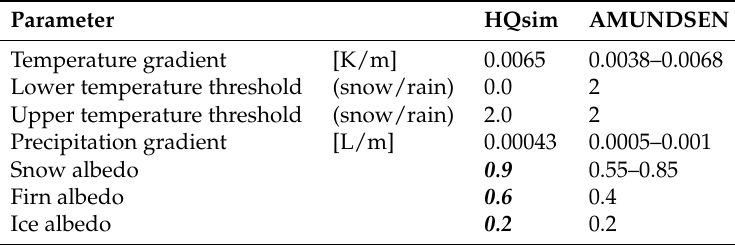
Table 3. Specific model parameters of both glacio-hydrological models HQsim and AMUNDSEN. Calibrated parameters are italic and bold. Model parameters for the glacier model GEM are identical to those in Marzeion et al.